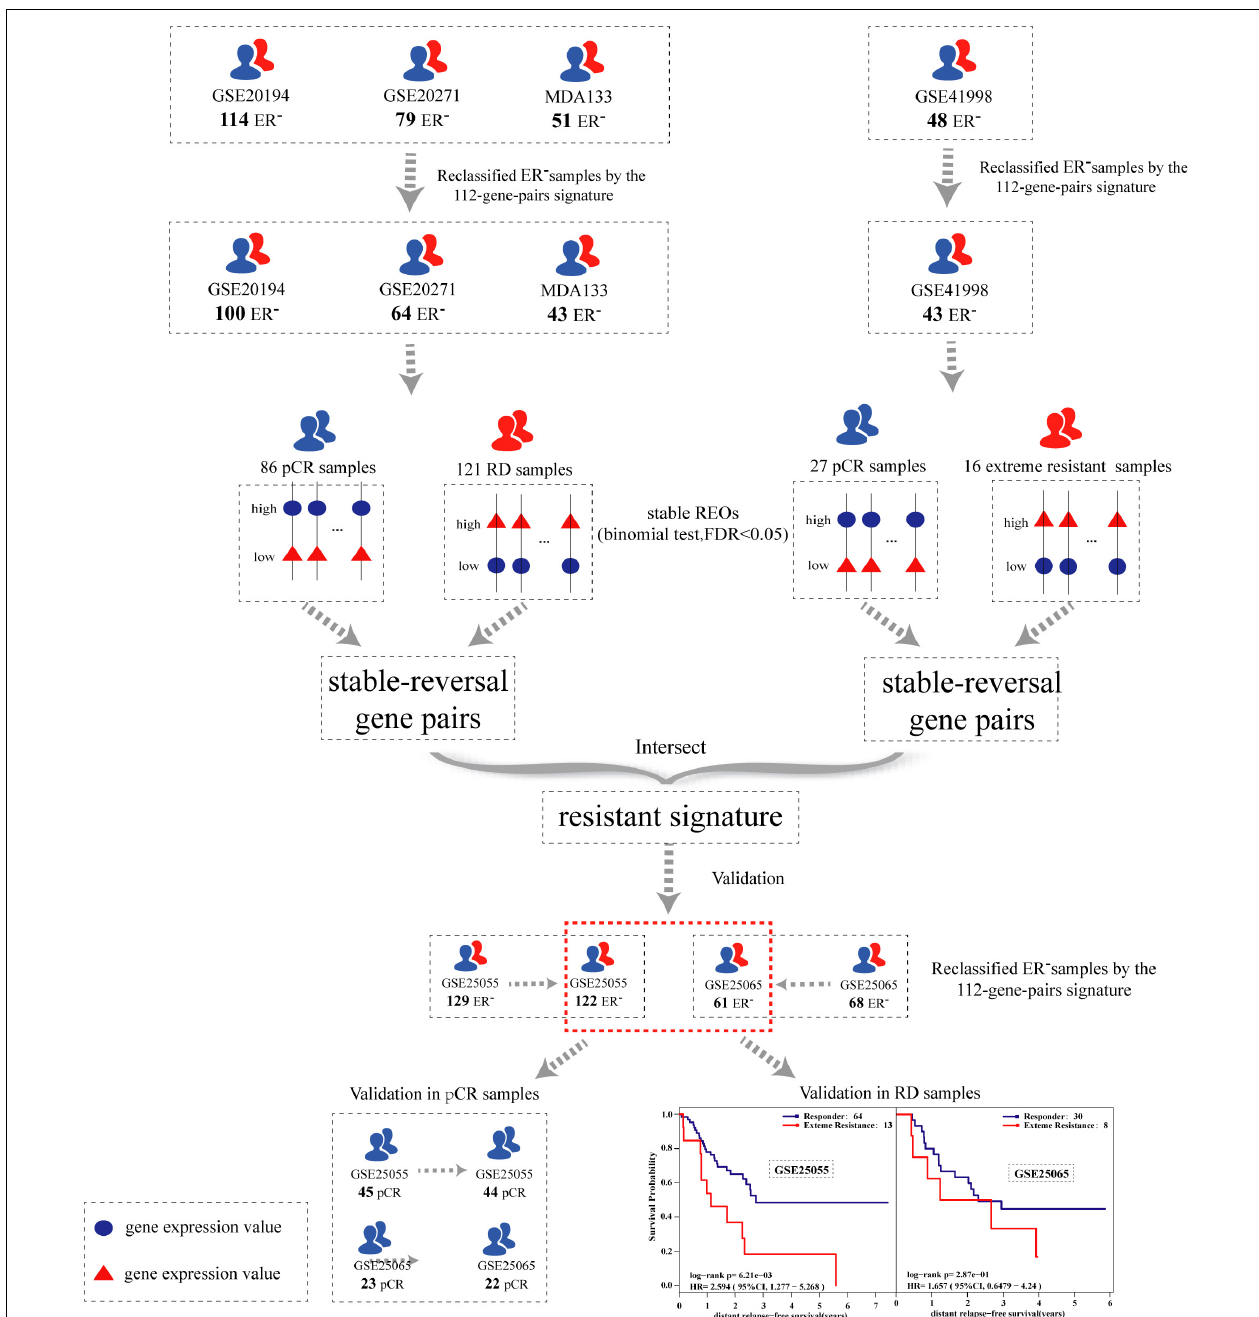
FIGURE 1 | The flowchart for developing and validating the resistant